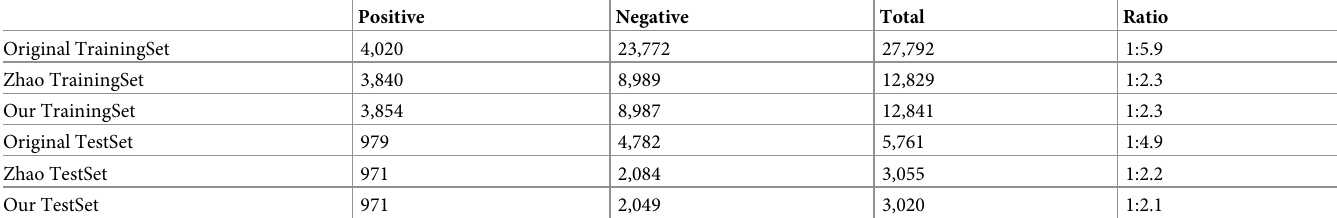
Table 4. The statistics of the DDIExtraction Challenge’13 corpus after preprocessing.